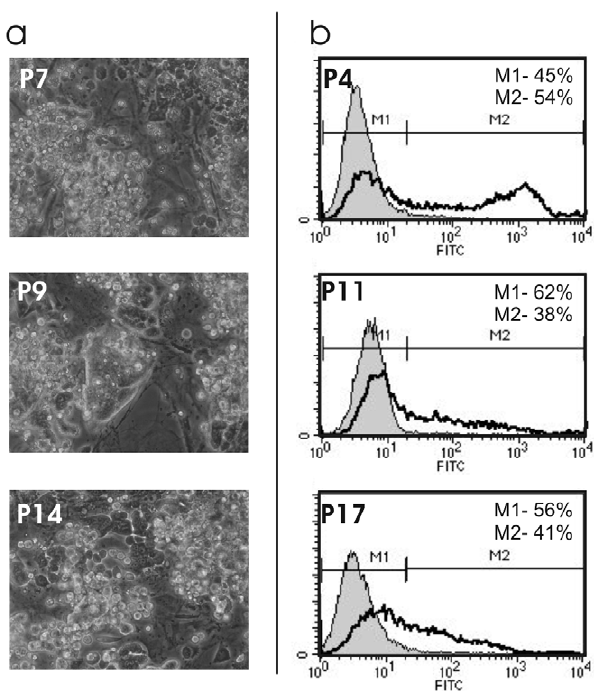
Figure 1. Morphology and SSEA 1 expression of wildtype TiB7- 4 iPS cells. a ) Morphology of TiB7-4 cultures at different passages of culture. b ) Expression of stage specific embryonic antigen (SSEA1) at different passages of culture determined by flow